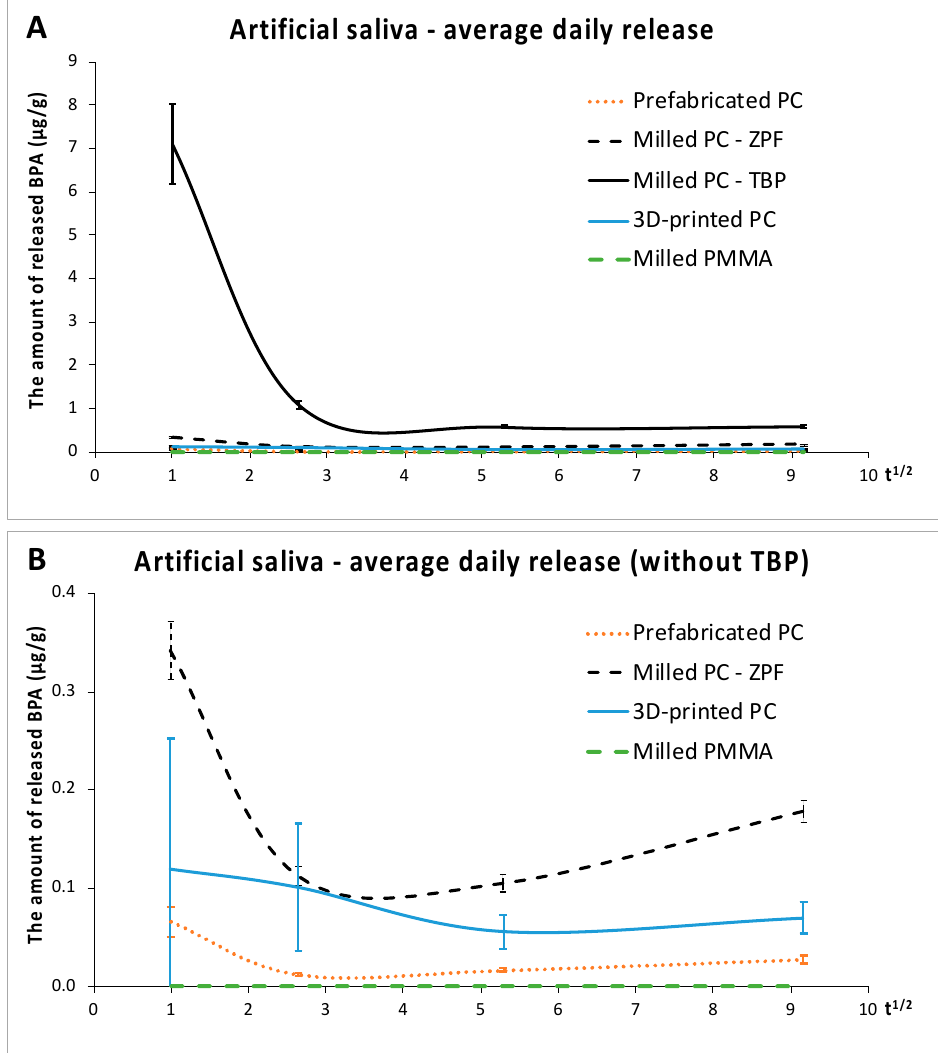
Figure 4. Average daily release of BPA in the artificial saliva ( μ g/g). ( A ): comparison of all materials, ( B ): comparison of materials without Tizian Blank Polycarbonate. Abbreviations as in Figure 3.